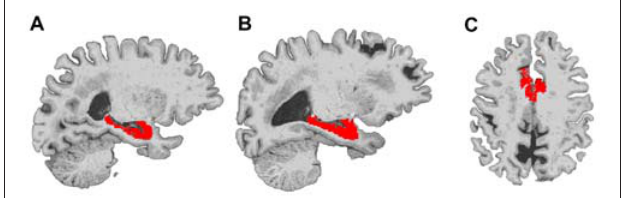
FIGURE 1 | Example locations of bilateral hippocampus and dorsal anterior cingulate cortex (dACC) regions used in Freesurfer volume analyses. The right hippocampus (A) , left hippocampus (B) and dorsal ACC (C) are displayed in red on a representative subject’s brain